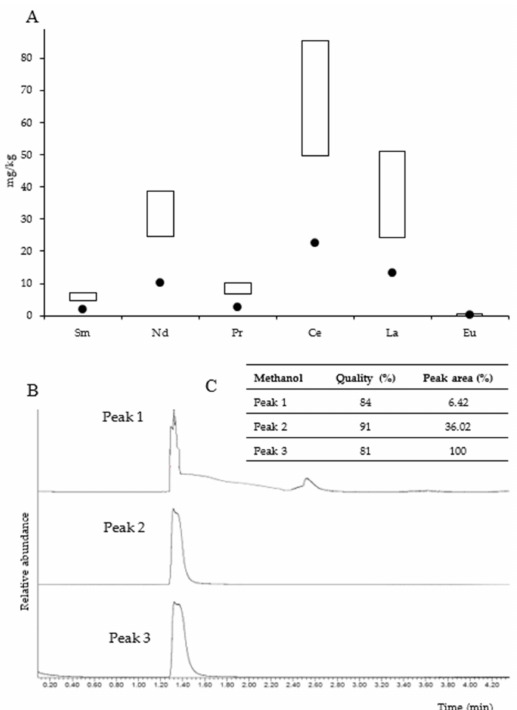
Figure 5. Content of light lanthanides in the microbial community (dots) and black shale (rectangles) (concentration ranges) ( A ). Detection of methanol in the microbial community—total ion gas chro- matogram (fragments of chromatograms are presented without a unified scale of relative abundance axis) ( B ) and methanol identification ( C